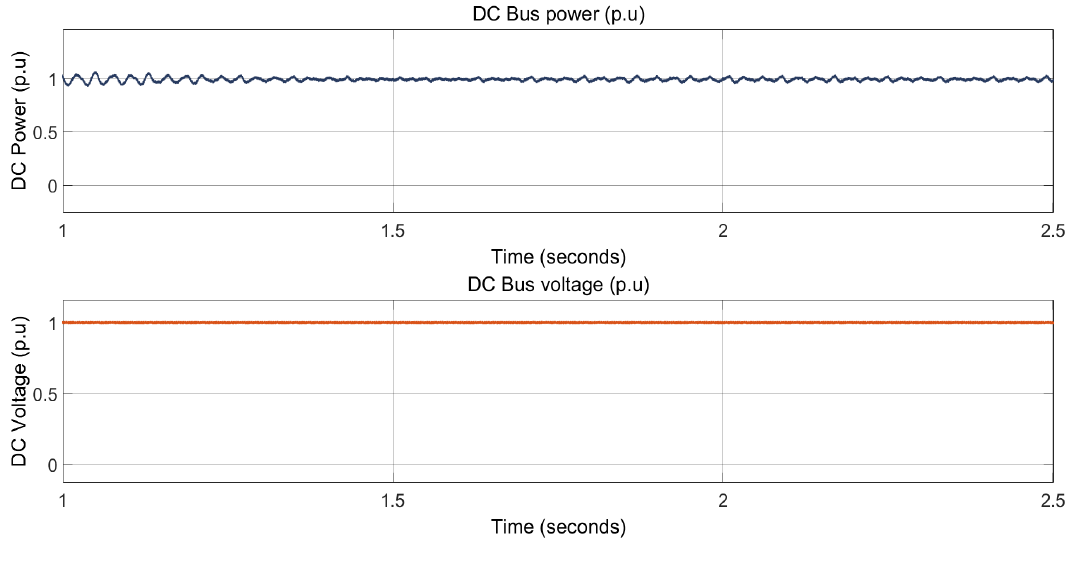
Figure 14. DC voltage control of the MMC-rectifier.